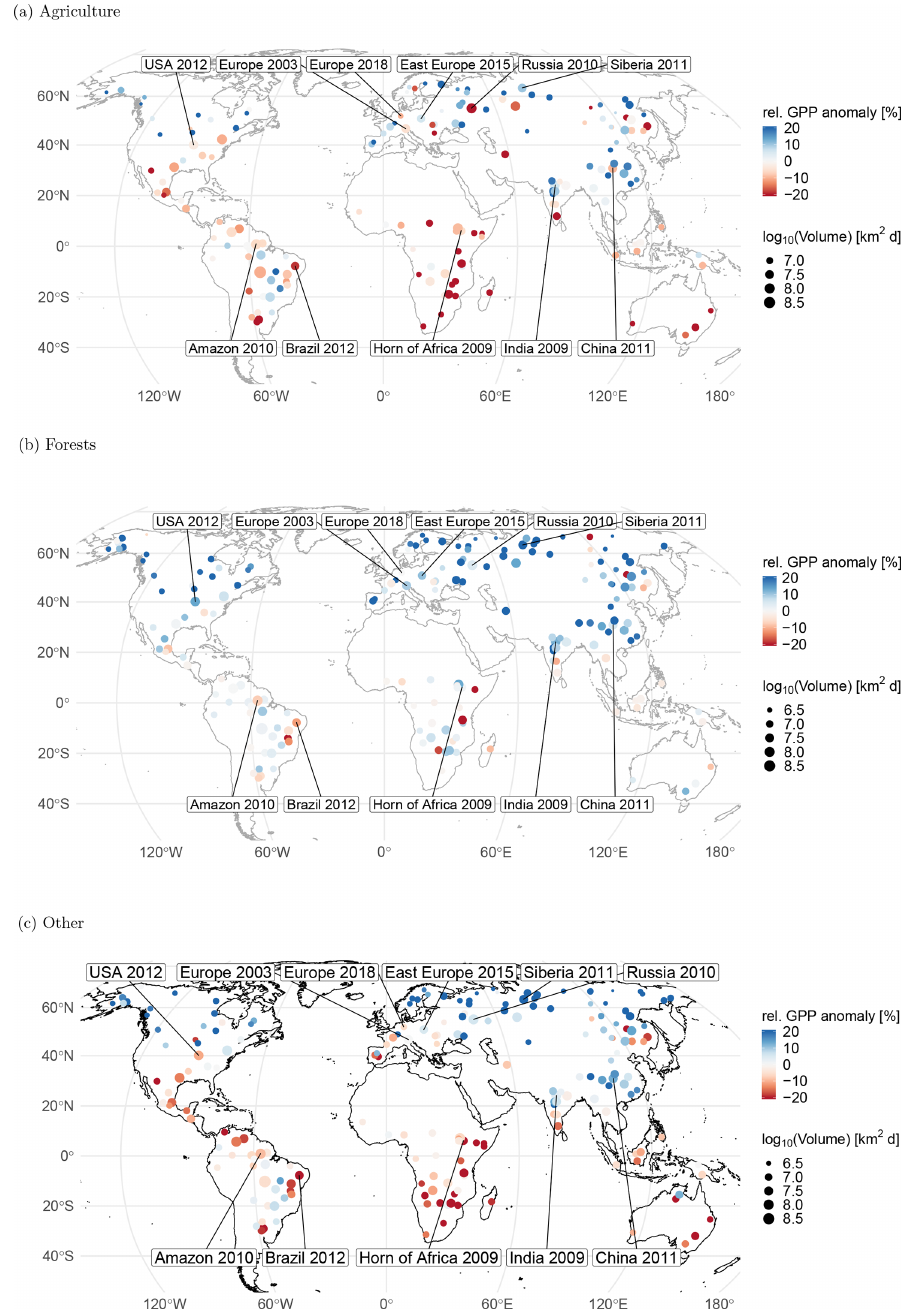
Figure 2. Relative drought and heat events colored with the relative anomaly in gross primary production for (a) agricultural, (b) forest, and (c) other ecosystems. Point sizes are proportional to the affected volume of the space–time event. The largest and some well-known events are labeled. Note that one single extreme event can affect adjacent grid cells. Each of these adjacent grid cells may be dominated by a different ecosystem type. These extreme events will appear more than once, i.e., in (a) , (b) , and (c) , each with the grid cells of part of the extreme event affecting the respective ecosystem. Labels are as follows: compounding drought and heatwave in the United States 2012, most commonly known as US drought 2012 (USA 2012); compounding European drought and heatwave 2003, commonly known as European heatwave 2003 (Europe 2003); compounding European drought and heatwave 2018 (Europe 2018); compounding eastern European drought and heatwave 2015 (Europe 2015); Siberian heatwave 2011 (Siberia 2011); compounding western Russian drought and heatwave 2010, commonly known as Russian heatwave 2010 (Russia 2010); compounding Amazon drought and heatwave 2010, mostly known as Amazon drought 2010 (Amazon 2010); drought in Brazil 2012 (Brazil 2012); compounding drought and heatwave at the Horn of Africa 2009 (Horn of Africa 2009); compounding Indian drought and heatwave 2009 (India 2009); and compounding drought and heatwave in China 2011 (China